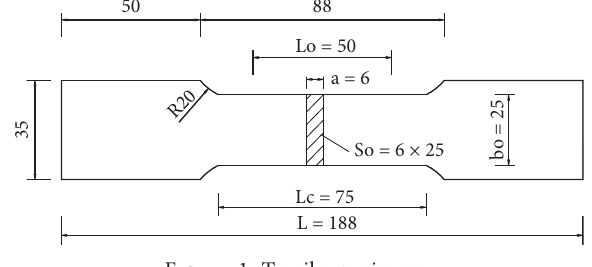
Figure 1: Tensile